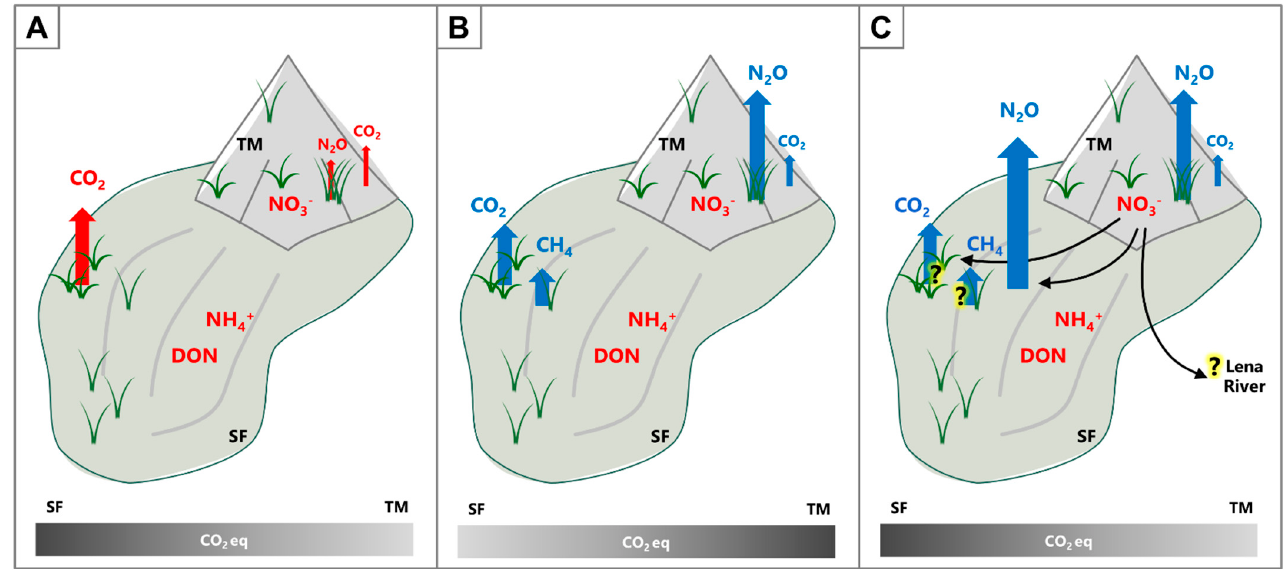
Figure 5. Possible scenarios for GHG release from the slump floor (SF) and thaw mounds (TM) of a retreogressive thaw slump. Red indicates rather aerobic than anaerobic conditions, while blue indi- cates rather anaerobic than aerobic conditions. The size of the arrows represents the strength of the flux. ( A ): During the growing season, TMs are well aerated and provide together with a neural soil pH good conditions for nitrification. Nitrate (NO 3 − ) can accumulate throughout the season even under a vegetation coverage. The SF is affected by meltwaters increasing soil moisture. High soil moisture and low pH of SF soils slow down or inhibit nitrification leading to an accumulation of DON and ammonium (NH 4+ ). N 2 O via nitrification and CO 2 losses from TM soils are relatively small [6,26] and more CO 2 equivalents are produced from the SF. ( B ): When the TMs become anaerobic in the end or beginning of the next growing season after rain events or snow melt, accumulated nitrate can be reduced via denitrification to N 2 O and less CO 2 is produced due to the slowdown of SOM decomposition. When the SF becomes predominately anaerobic, it produces in addition to CO 2 , also CH 4 , but no N 2 O since denitrification is nitrate limited at the SF. Due to the GWP of N 2 O, more CO 2 equivalents are released from TMs, CH 4 emissions play a minor role. ( C ): When nitrate is leached from the TMs towards the SF by meltwaters or soil erosion, it removes the nitrate limitation for the denitrification at the SF and leads to high N 2 O losses. Nitrate leaching might also affect CO 2 and CH 4 production or adjacent aquatic ecosystems (here Lena River).